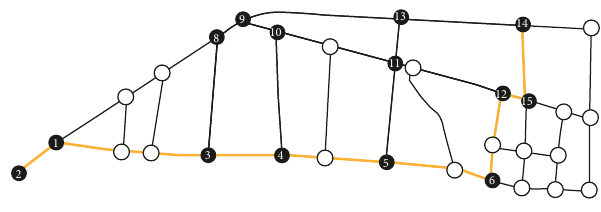
Figure 8: Long-distance path